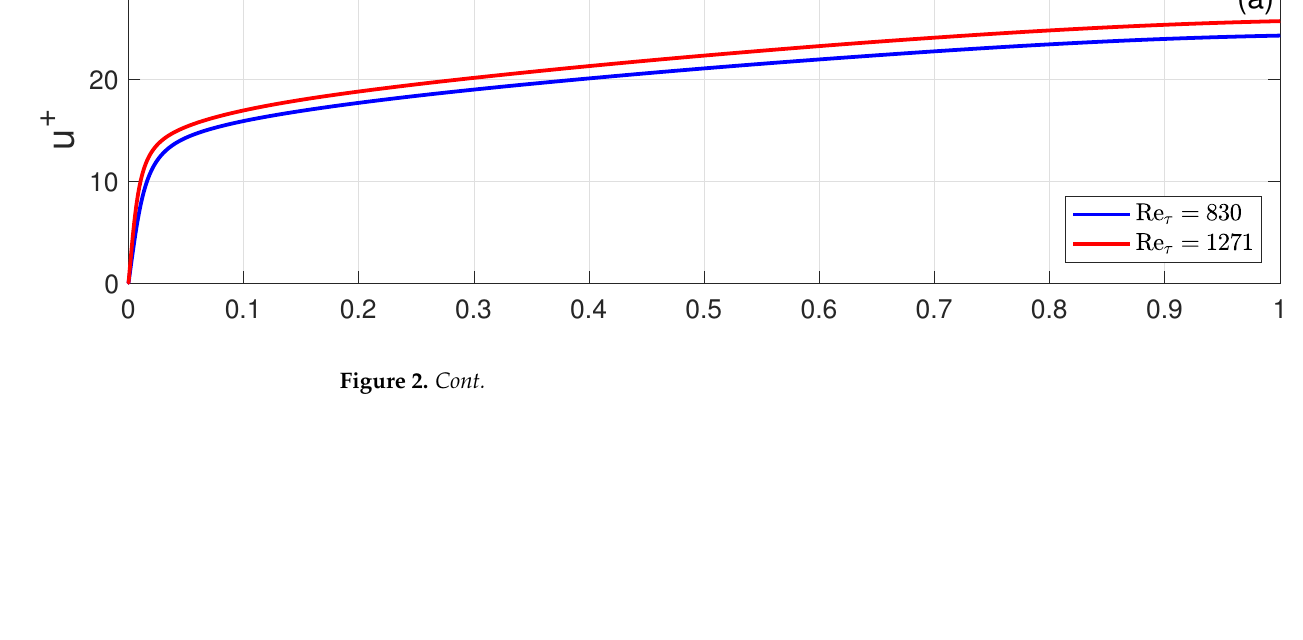
Figure 2. Profiles of non-dimensional velocity ( a ), shear stress including both viscous stress du + /dz + and Reynolds stress < u 0 w 0 > + ( b ) and dissipation rate ( c ) as a function of z / δ (depth normalized by the boundary layer thickness) in the DNS of non-rotating BBL. 4. Vertical Structures of the BBL 4.1. Non-Rotating BBL Along with the thin layer containing the large velocity shear is enhanced viscous stress and the associated dissipation of mean kinetic energy (MKE) within the BBL (Figure 2b,c). The viscous stress is dominant for z / δ / 0.02 due to both the enhanced velocity shear and the damping of Reynolds stress in the presence of the solid bottom. Again, the distribution of the total shear stress provides support for the linear approximation made in the idealized heuristic model in the last section. As Re τ increases, both the viscous and Reynolds stress become closer to the bottom, but the structure of the total shear stress remains relatively unchanged (Figure 2b).